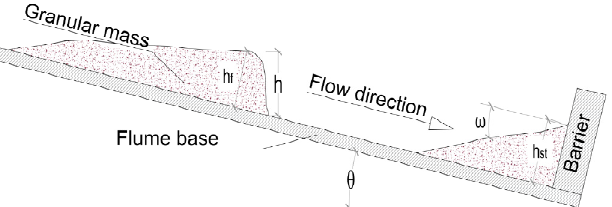
Figure 2. Definitions of mass movement during the flow movement and in the final state, flow depth h and h f , height of discharge h st and angle of discharge ω .